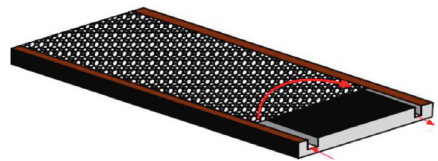
Figure 13: Flow field pattern inside gob.